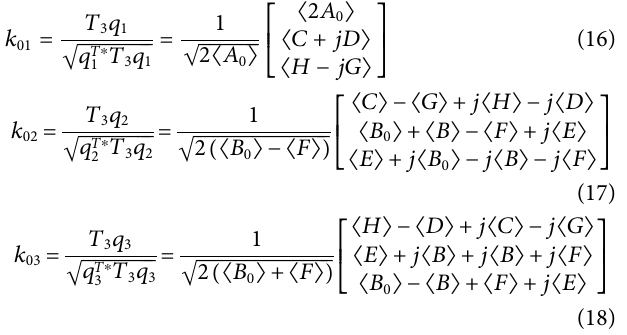
Raneydecomposition was used on the 2 × 2 coherency matrix elements ( Eq. 7 ) retrieved from the CP dataset to extract the surface → and volume → components. Figure 3 represents the color-coded RGB image of Raney scattering components obtained from CP RISAT-1